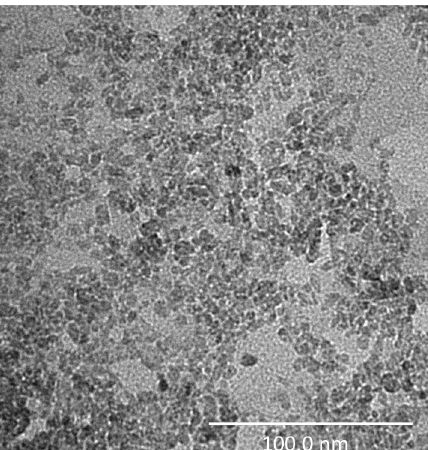
Figure 7. High-resolution Transmission Electron Microscopy (TEM) image of the TiO 2 -based sample. The investigation was performed using a Tecnai G2 Spirit (FEI) operated at 120 kV (scale bar = 100 nm).